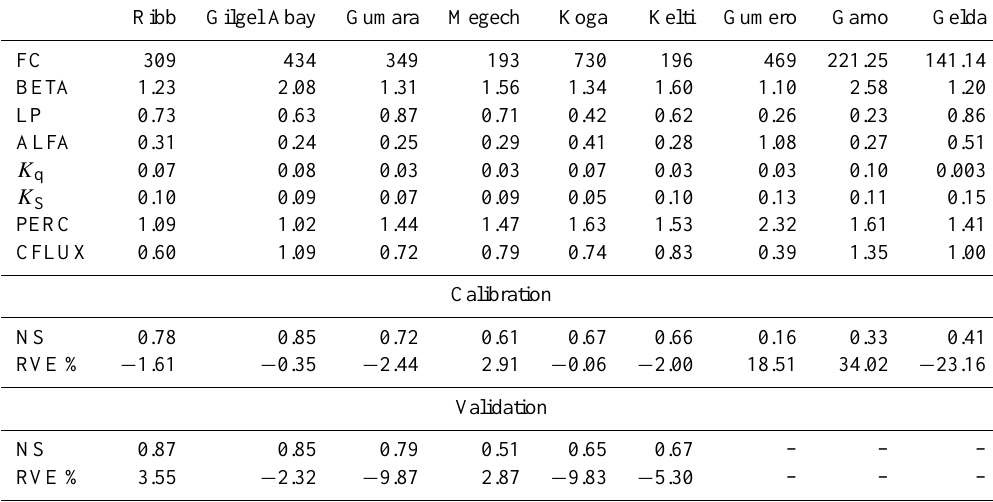
Table 3. Optimized model parameters for gauged catchments